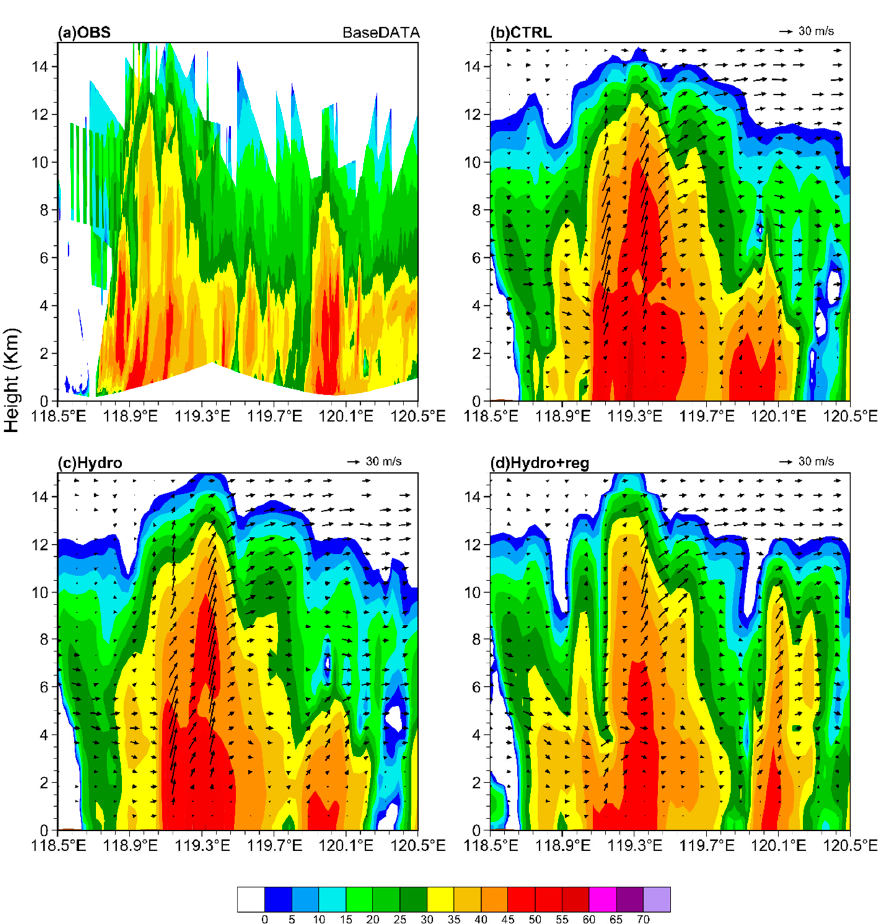
Figure 13. Cross-sections over line AB of the reflectivity (shaded, units: dBZ) and wind (vector, the vertical velocity has been multiplied 10) field at 0920UTC from ( a ) Observation, ( b ) CTRL, ( c ) Hydro and ( d ) Hydro+reg experiments after 3 cycles.